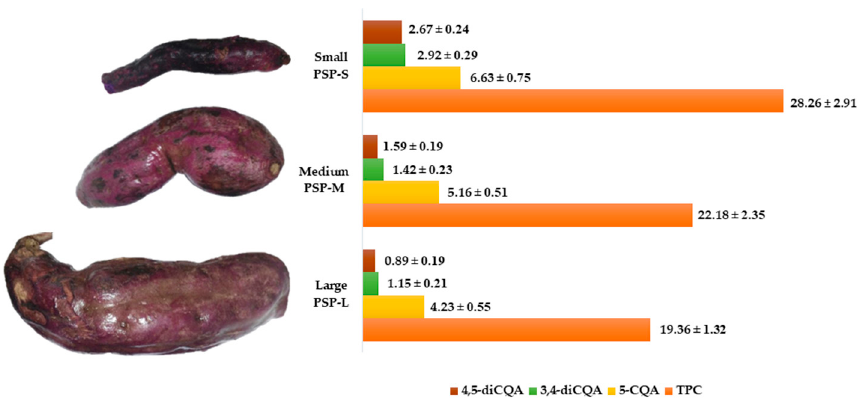
Figure 1. Total polyphenolic content (TPC), 5-CQA, 3,4-diCQA and 4,5-diCQA concentrations measured in 3 size of Mexican PSP: large (PSP-L), medium (PSP-M), and small (PSP-S). Each bar is the mean accompanied of the mean value ± SD of three independent experiments. Table 1. CQA-derivatives in PSP identified by mass spectrometry (HPLC-MS).